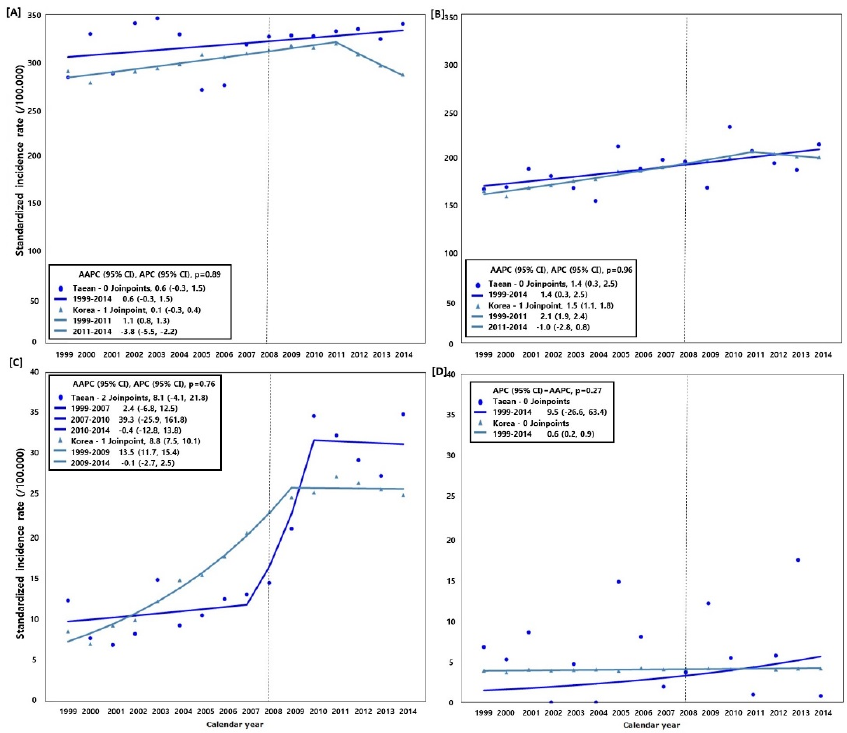
Figure 2. Comparison of the cancer incidence rate and average annual percent change (AAPC) between Taean and the whole of Korea, 1999 − 2014; Model selection and p -value estimated using the Monte Carlo Permutation method. ( A ) All cancers (C00 − C96) excluding thyroid cancer (C73) in men; ( B ) All cancers (C00 − C96) excluding thyroid cancer (C73) in women; ( C ) Prostate cancer (C61); and ( D ) Leukemia (C91 − C95) in women. The Hebei Spirit oil spill (HSOS) occurred in 7 December